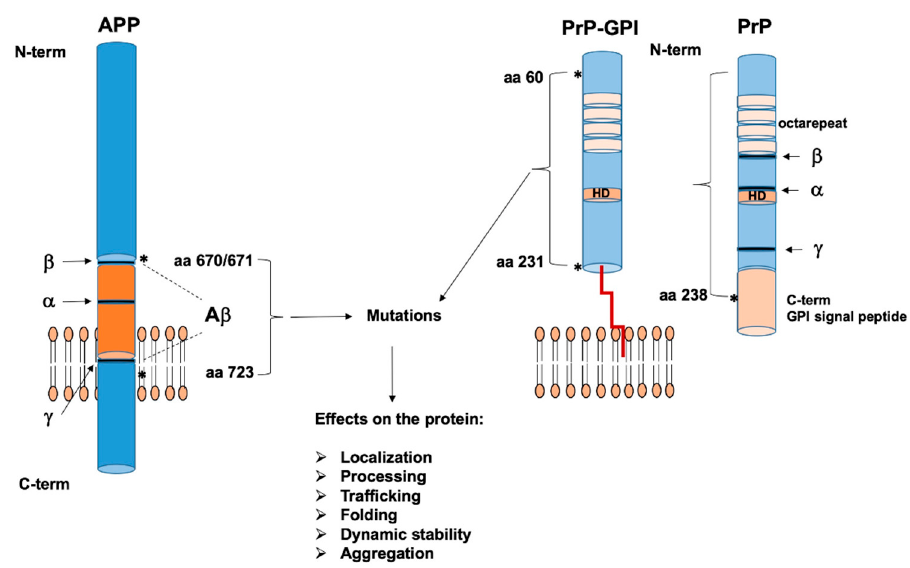
Figure 2. Schematic illustration of A β precursor protein (APP) and prion protein (PrP) pathogenic mutations. Sites of α -, β -, and γ -secretase cleavage are indicated by arrows on both proteins. Asterisks near braces point to currently known mutations in APP and PrP: from aa670 / 671 to aa723 in APP; from aa60 to aa231 in glycosylphosphatidylinositol (GPI)-anchored PrP and to aa238 (present in the GPI-attachment signal) in unprocessed PrP (carrying the GPI-signal peptide). To note: APP can be principally mutated into or nearby the A β sequence, while PrP can be mutated all along the sequence length. Effects of protein mutations are listed in the column. HD: hydrophobic domain.